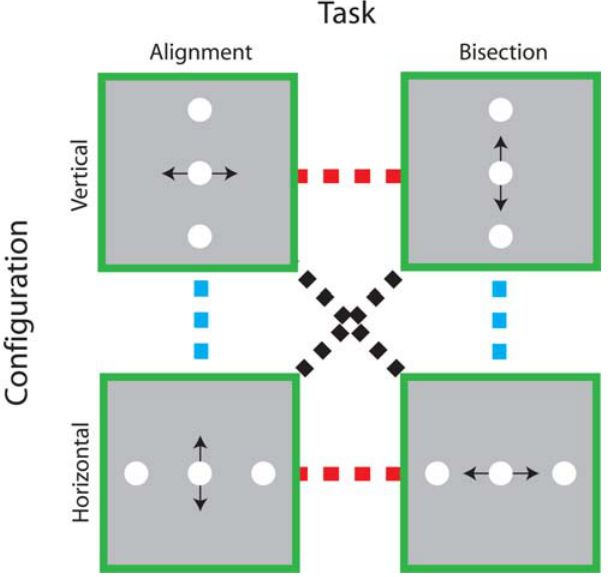
Figure 1. Decoupling the task and stimulus specificity of positional learning. Schematic illustrations of each of the task and stimulus configurations used in the experiment are shown in the green boxes. In each case, the black arrow indicates the spatial axis of the required positional judgement. To characterise the specificity of perceptual learning, subjects’ performance was measured on all four task- configuration combinations before and after they received training on one of them. In principle, trained improvements in performance on particular task-configuration combinations could be tightly coupled to the task (dashed blue lines), the stimulus configuration (dashed red line) or the spatial axis of the judgement (dashed black lines).